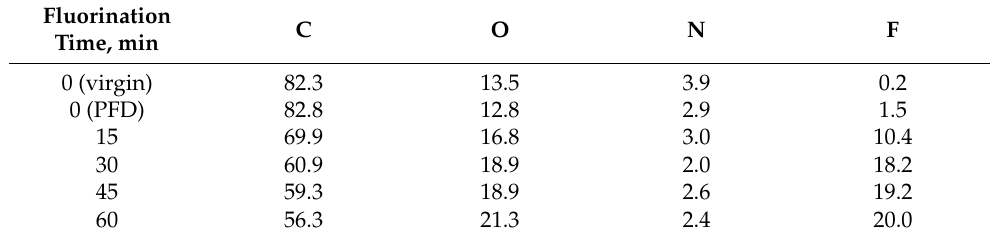
Table 2. Atomic concentrations (%) of C, O, F, and N in PIM-1 samples depending on fluorination time according to XPS